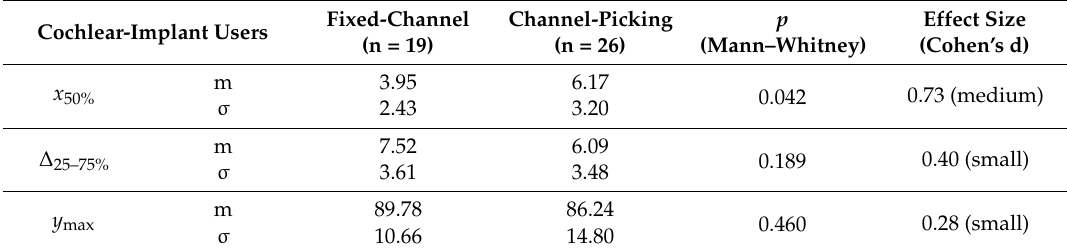
Table 5. Comparison of the analytical values, for cochlear implant users. Cochlear-Implant